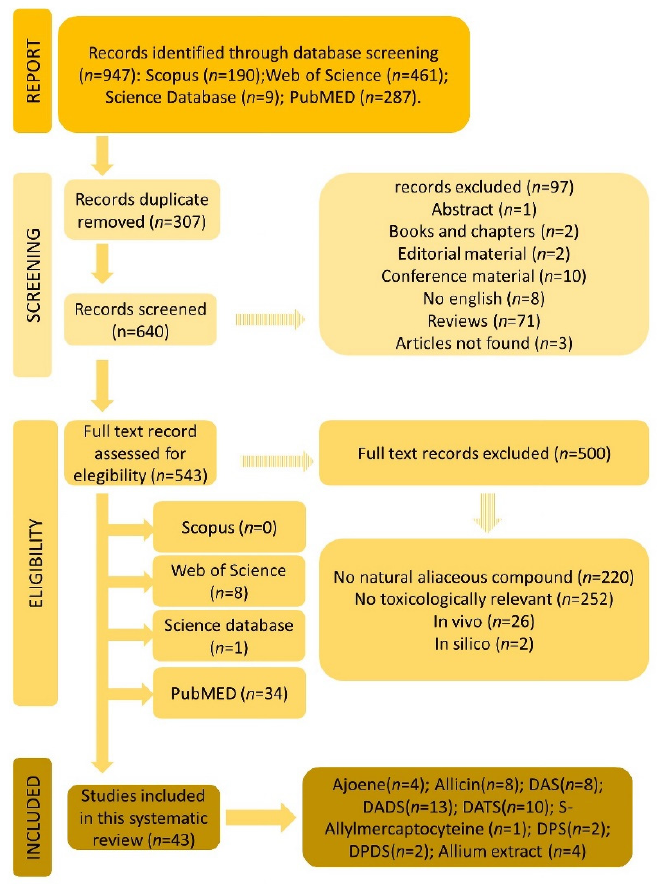
Figure 1. PRISMA flowchart of article selection.